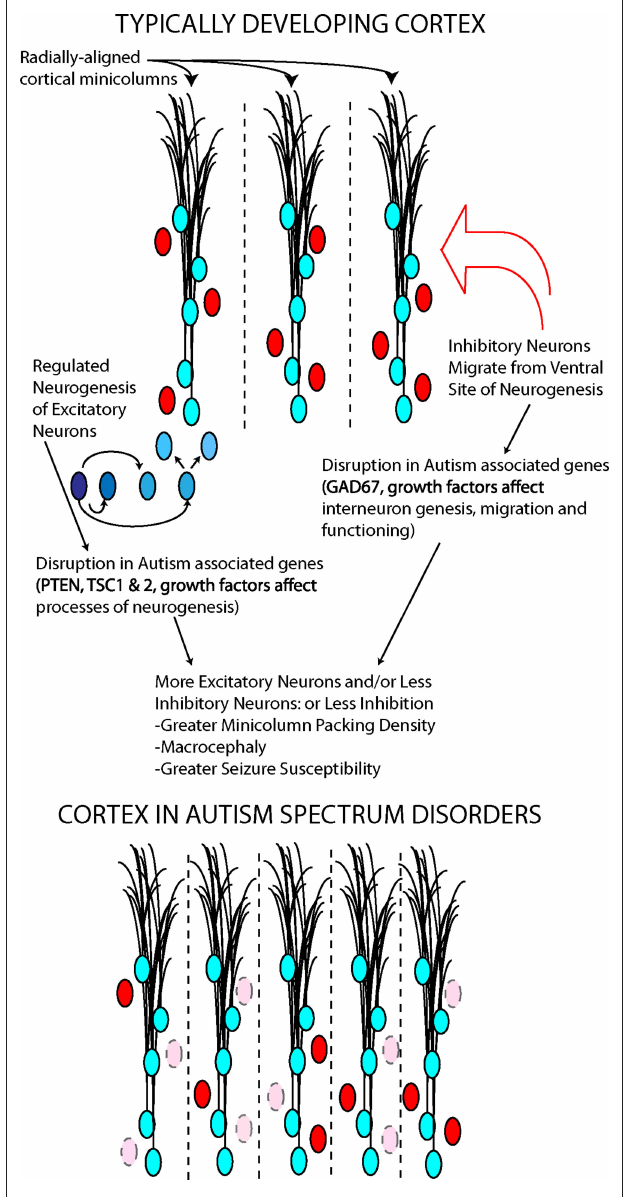
Figure 3 | Two neuronal cell types, excitatory (blue) and inhibitory (red), contribute to minicolumn structure and functional balance in cortex. Autism associated genes play roles in the processes underlying the generation and migration of these cortical neurons. The disruption of these genes may determine some cortical abnormalities in